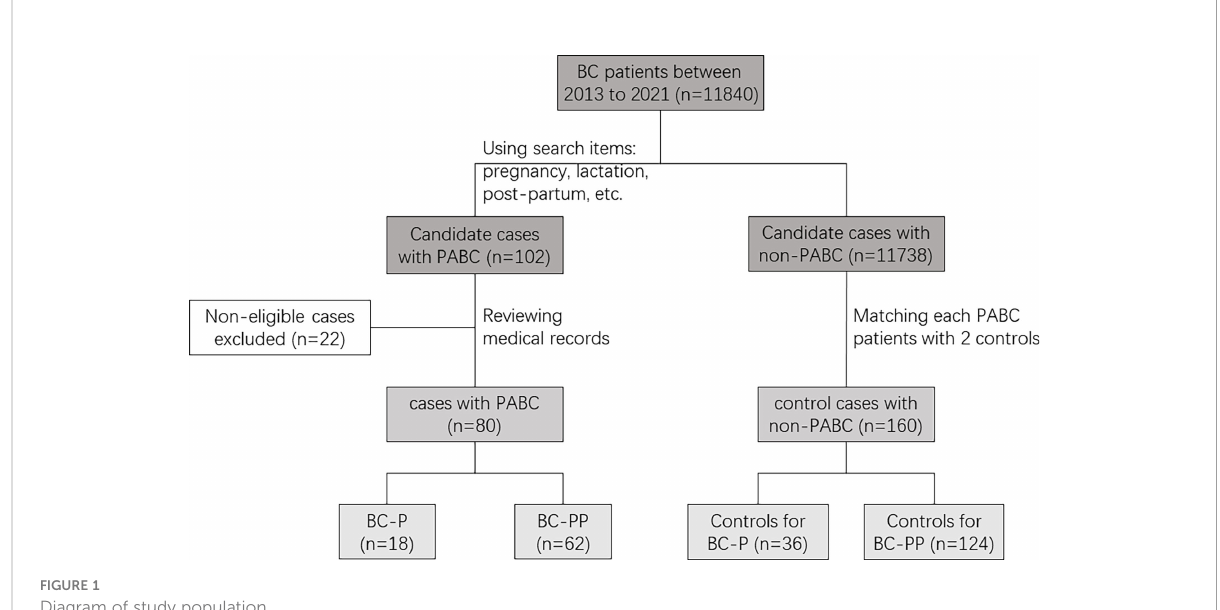
FIGURE 1 Diagram of study